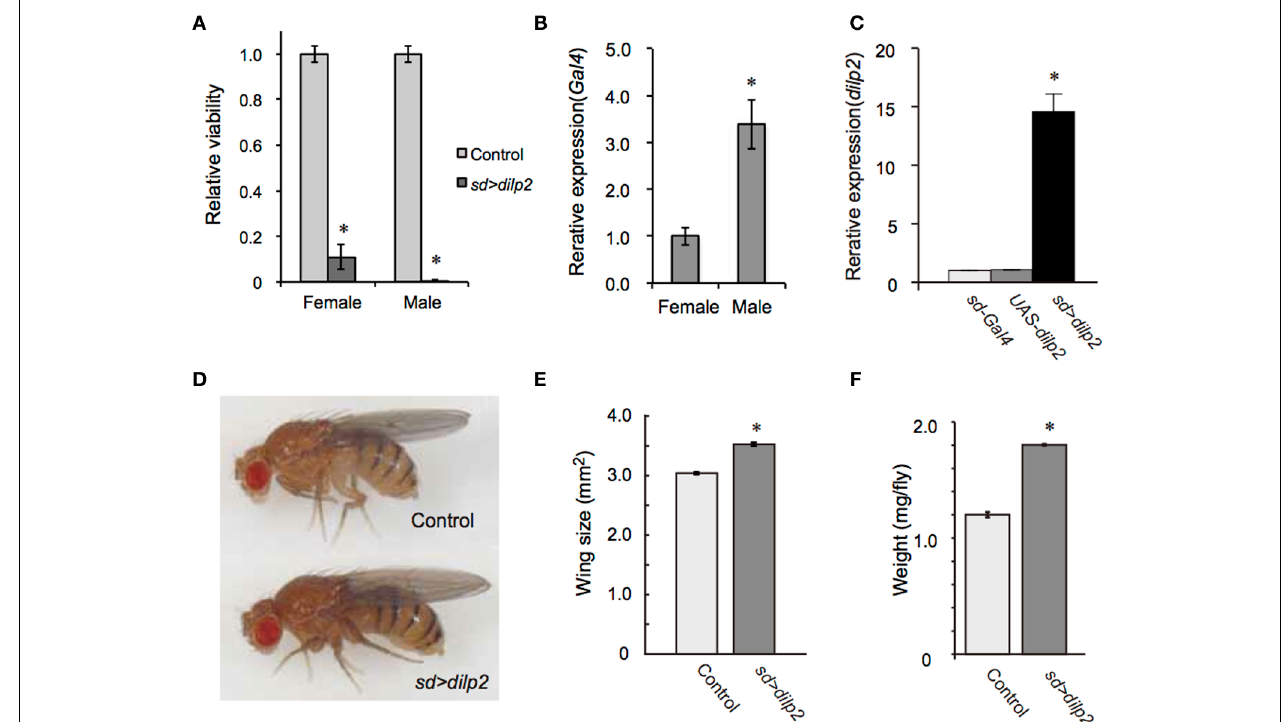
FIGURE 1 | Overexpression of dilp2 increases body size and causes semi-lethality. Relative viability of dilp2 -overexpressing flies (A) . Flies homozygous for sd-Gal4 were crossed with UAS-dilp2 / 3xP3-RFP males, and the number of flies expressing RFP served as an internal control; those not expressing RFP are expressing dilp2 . Expression level of Gal4 in sd-Gal4 male is much higher than that of sd-Gal4 female (B) . Overexpression of dilp2